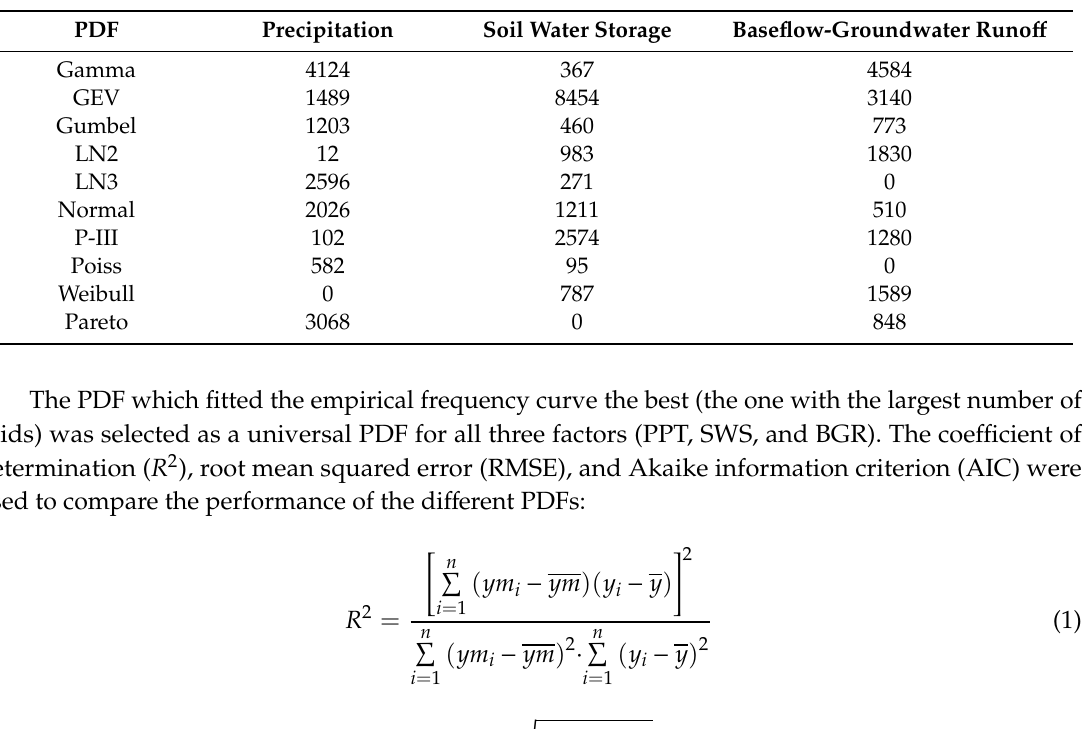
Table 1. Grid number of the selected PDFs for spatiotemporal variations of precipitation (PPT), soil water storage (SWS), and baseflow-groundwater runo ff (BGR) (assessed by the minimum Akaike information criterion (AIC)